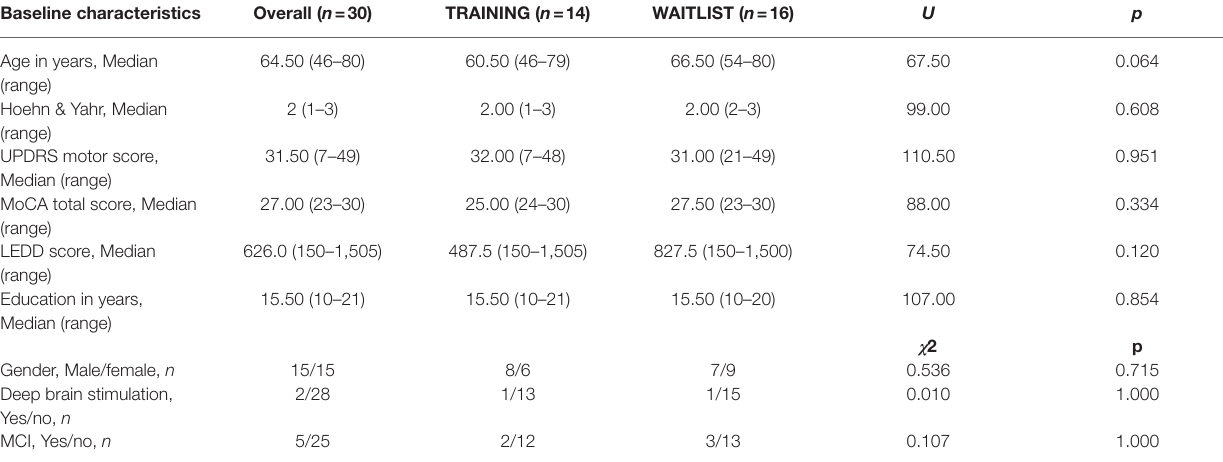
TABLE 3 | Baseline sample characteristics for both groups and in